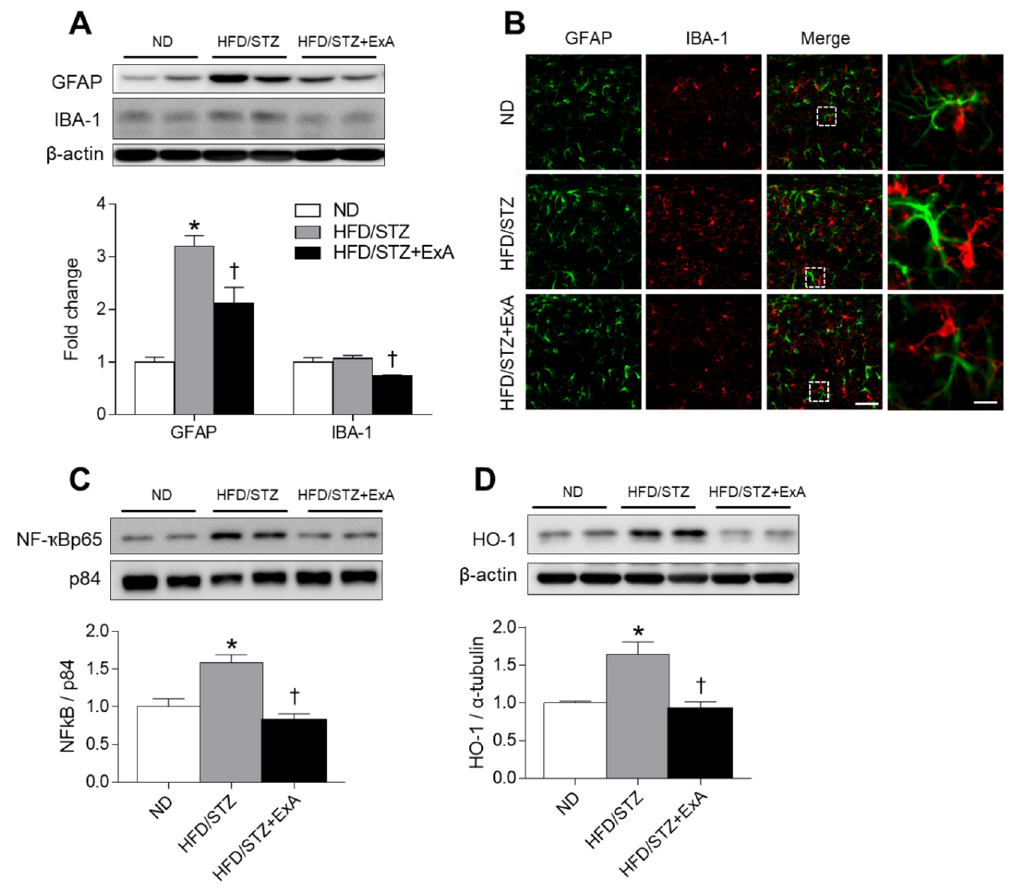
Figure 6. Effects of long-acting exendin-4-ABD-anti-FcRn affibody (ExA) on glial activation, NF- κβ , and HO-1 expression levels in the hippocampus of HFD/STZ mice. ( A ) Western blot and quantitative analysis results showing GFAP and IBA-1 expression in the hippocampus. ( B ) Immunofluorescence staining for GFAP (green) and IBA-1 (red) in the hippocampal CA1 regions of ND-fed mice, HFD/STZ mice, and ExA-treated HFD/STZ (HFD/STZ+ExA). Scale bar = 20 μ m. ( C,D ) Western blot analysis showing NF- κβ p65 ( C ) and HO-1 ( D ) expression in the hippocampus. Both p84 and β -actin were used as loading controls, respectively, for panels C and D. Data ( n = 3–4 mice per group) are shown as the mean ± SEM. *: p < 0.05 vs. ND-fed mice, †: p < 0.05 vs. HFD/STZ mice.